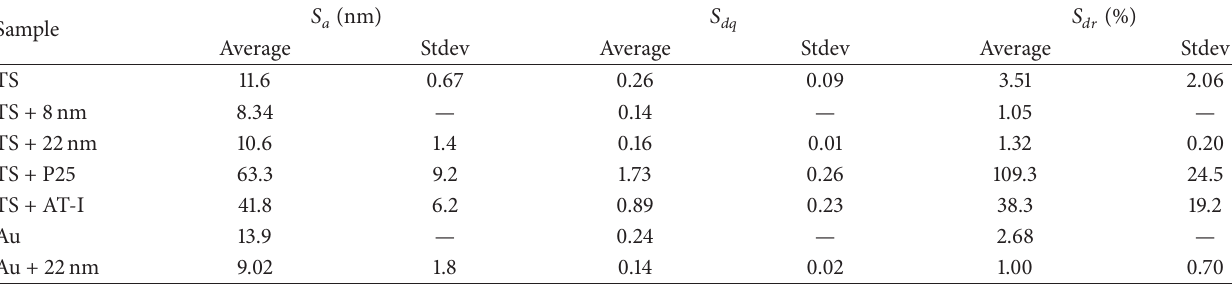
Table 2: 3 D surface roughness parameters determined by